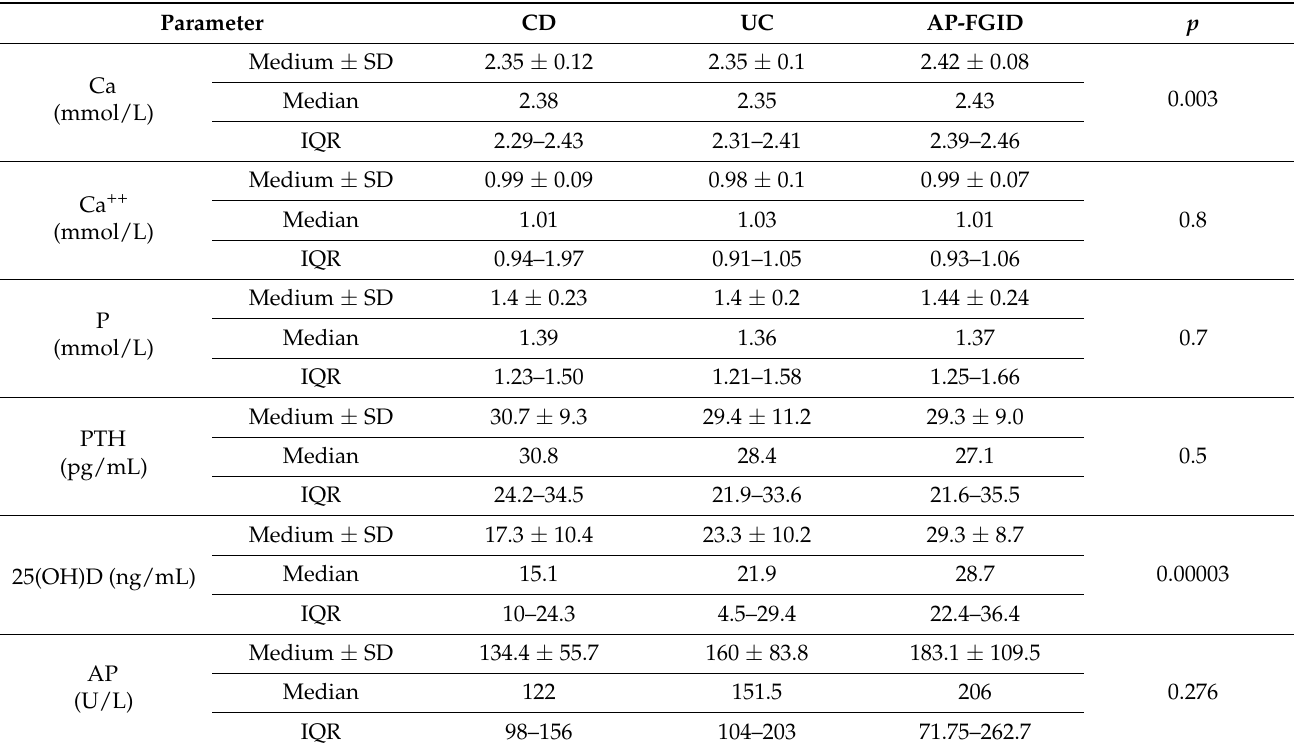
Table 2. The results of calcium and phosphate metabolism parameters determined from the serum and urine in the studied